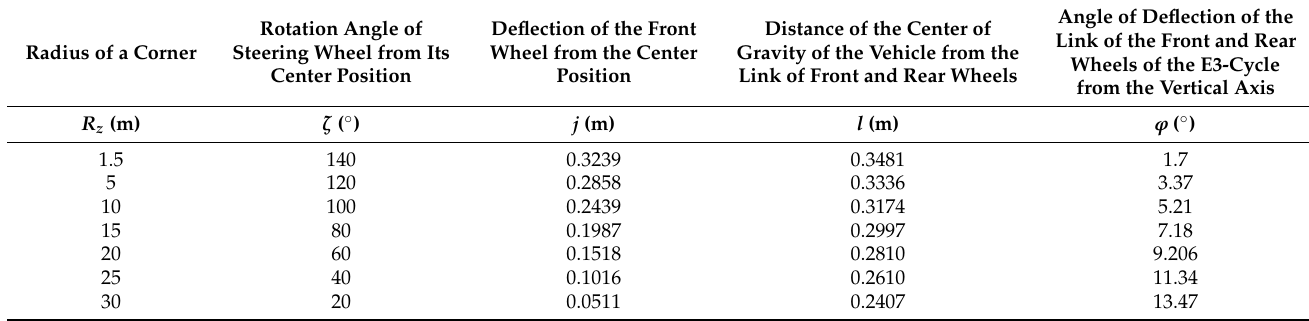
Table 1. Variable parameters of the E3-cycle depending on steering wheel angle.